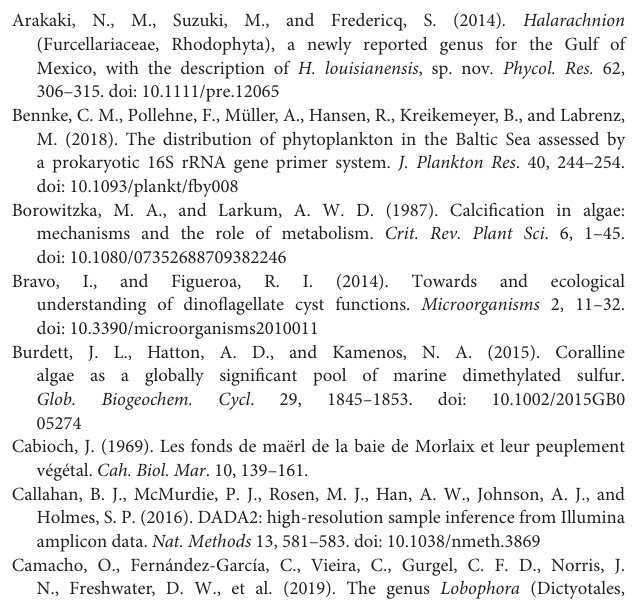
Supplementary Figure 1 | Map of the Gulf of Mexico showing collection locality data ( ). From left to right: West Flower Garden Bank (WFG), East Flower Garden Bank (EFG), Ewing Bank (EB), Sackett Bank (SB), and vicinity of the Dry Tortugas, Florida (DT), and site of the Deepwater Horizon Macondo Well Blowout ( ). Supplementary Table 1 | Taxon and collection data of plastid 16S reference sequences and GenBank accession numbers (including newly generated sequences shown in boldface ) and 16 V4 sequences of Halymeniaceae (Halymeniales) and Bonnemaisoniales. Newly generated 16 V4 OTUs are shown in red (NCBI SRA). SF, Suzanne Fredericq; DWF, Wilson Freshwater; MHH, Max H. Hommersand; JR, Jan